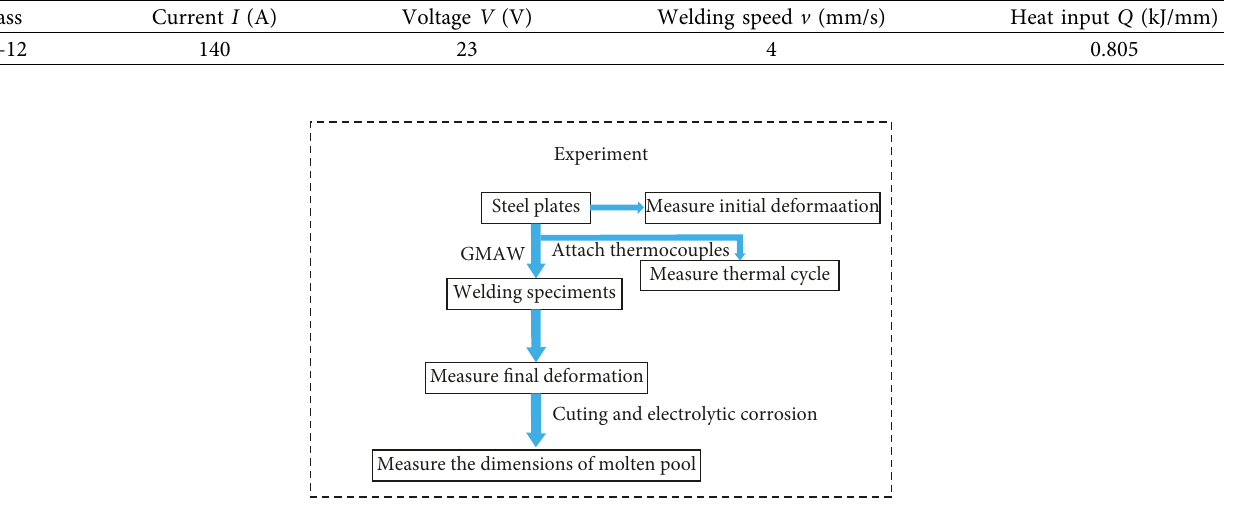
Figure 2: The diagram of the experimental system.